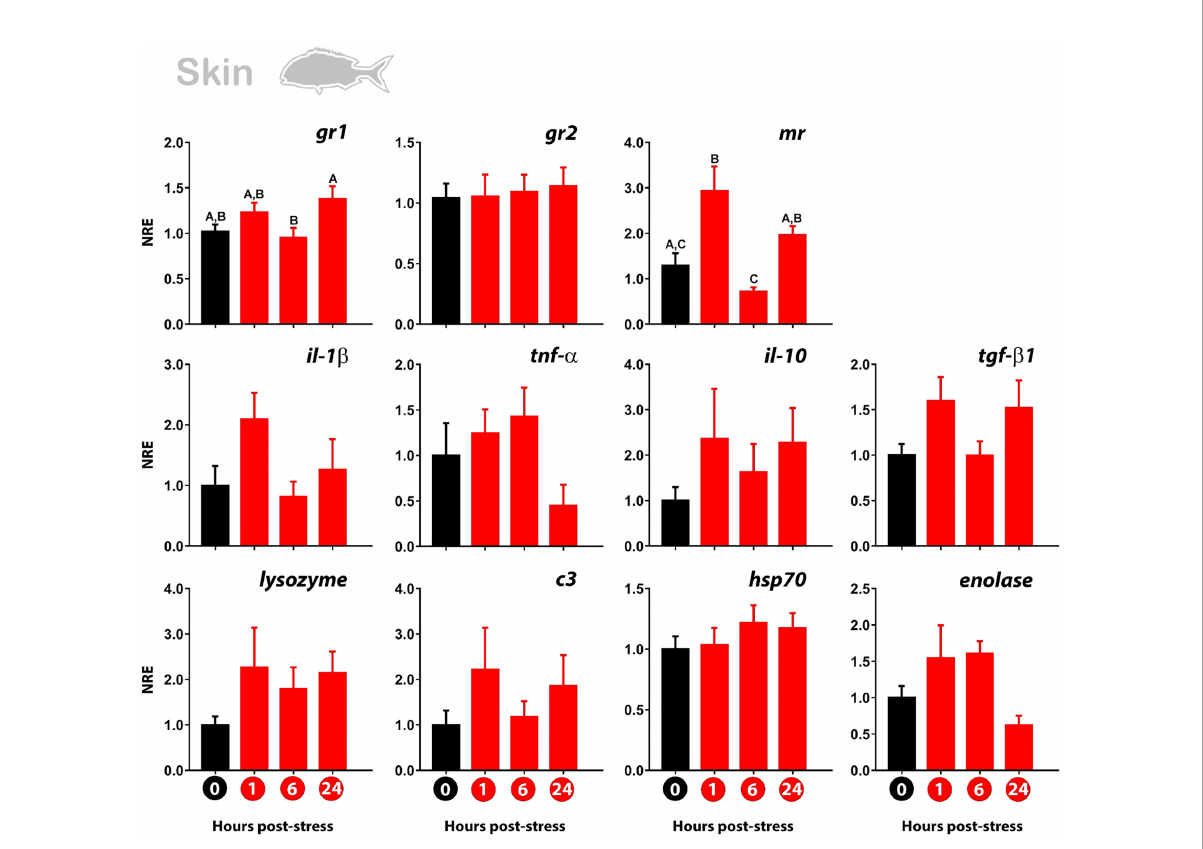
FIGURE 2 Normalized gene expression (NRE) pro fi le in the skin of gilthead sea bream subjected to acute stress by air exposure. Modulation of cortisol receptors ( gr1 , gr2 , mr ), immune ( il-1 b ; tnf- a ; il-10 ; tgf- b 1 ; lys ; c3 ), and stress response ( hsp70 ; enolase ) were evaluated by RT-qPCR. Bar values represent the mean ± standard error (n = 8 fi sh per treatment and time evaluated). Time zero represents the control group (non-stressed fi sh; black bar). The modulation of gene expression at 1 hour, 6 hours, and 24 hours post-stress (red bars) is represented. The rpl27 was used as reference gene. The signi fi cant differences between the different times are presented with a capital letter on each bar. The absence of letters indicates that there are no signi fi cant differences in the times evaluated (one-way Anova; p<0.05). gr1 , glucocorticoid receptor 1; gr2 , glucocorticoid receptor 2; mr , mineralocorticoid receptor; il-1 b , Interleukin 1-beta; tnf- a , tumor necrosis factor-alpha; il-10 , interleukin 10; tgf- b 1 , tumor growth factor-beta 1 ; lys , lysozyme; c3 , complement protein c3; hsp70 , heat shock protein